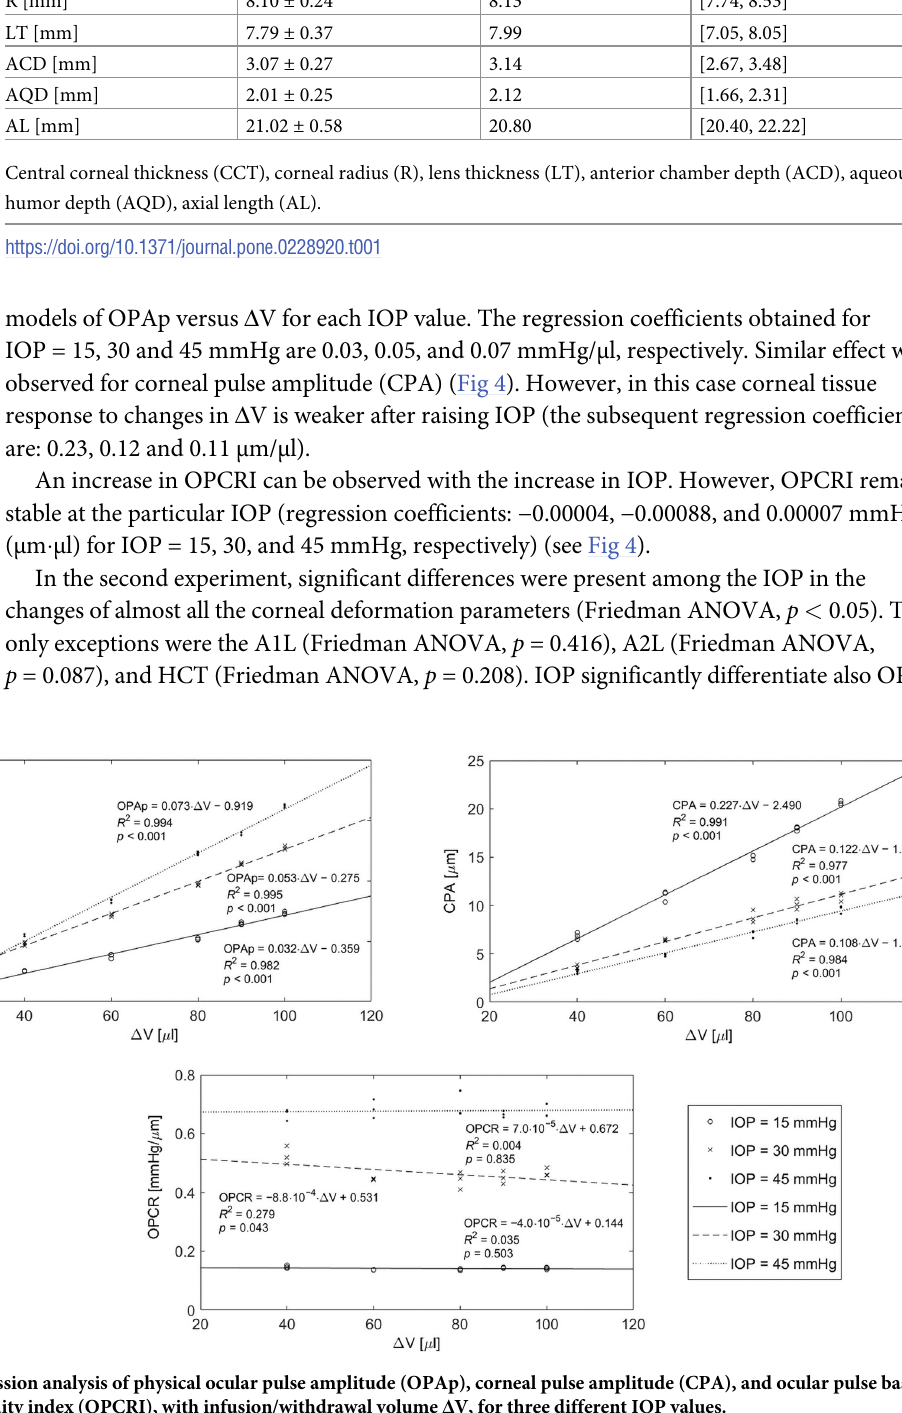
Table 1. Summary of data.